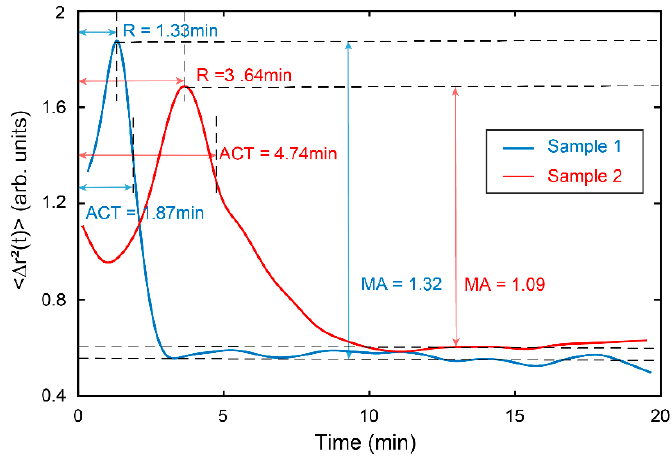
Figure 4. Time traces of coagulation measured from the blood samples by using 35 µL (red line) and 70 µL (cyan line) 0.2 M calcium chloride to initiate the blood coagulation. It is clear that both R-time and ACT were significantly prolonged when calcium chloride used was decreased from 70 µL to 35 µL. In contrast, the MA decreased as the calcium chloride used decreased.